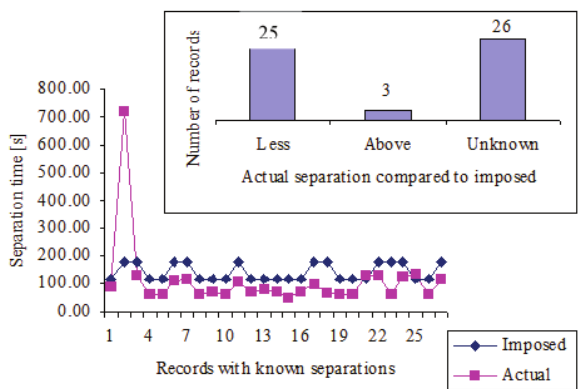
Figure 11. Reported time separations compared to the UK imposed separations